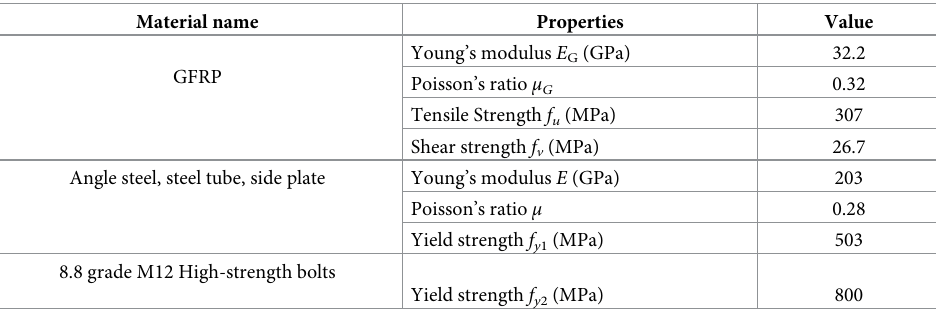
Where L was the horizontal distance between loading point and column edge of joint, whose value was 950 mm; L and L were the vertical displacements measured by displacement 1 2 Table 2. Material parameters of